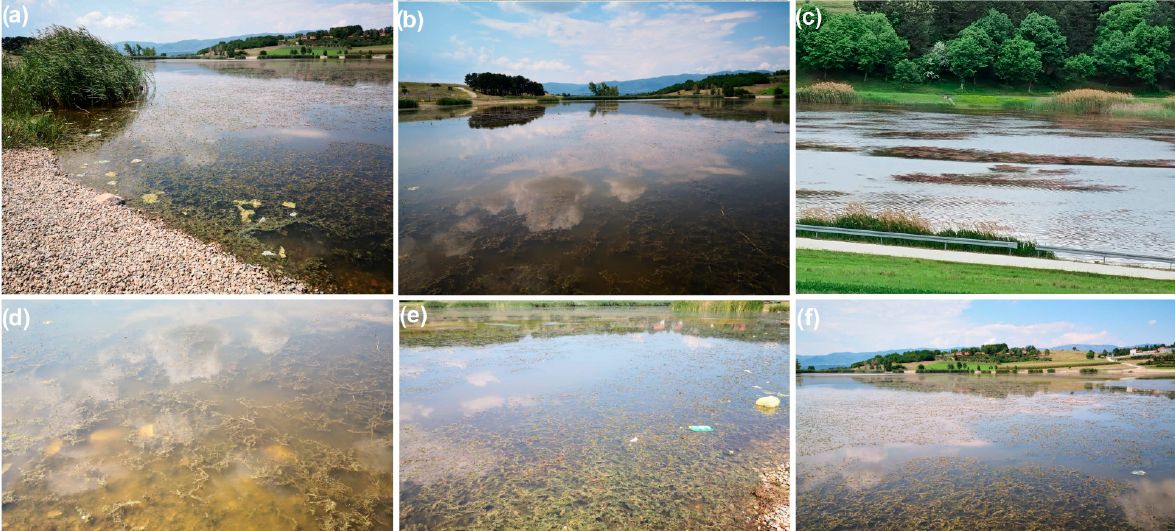
Figure 7. Visually determined the coverage of the lake by the submerged macrophytes: ( a – c ) ob- servation of the whole Lake; ( d – f ) observation of the coastal part of the Lake. vation of the whole Lake; ( d – f ) observation of the coastal part of the